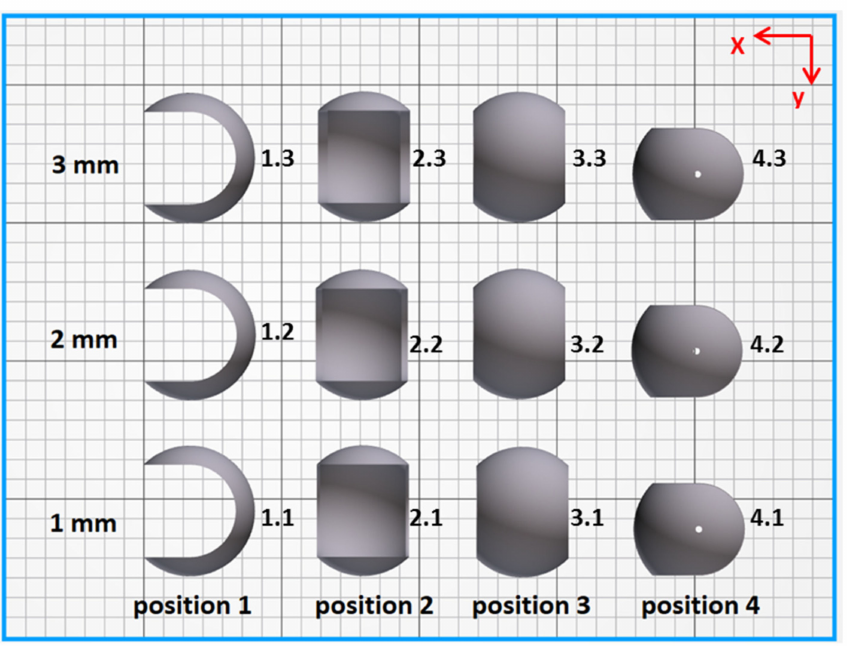
Figure 3. The orientation of analyzed parts in the printing chamber (top view); the samples are labeled X.Y, by position (X: 1–4) and thickness (Y: 1–3),